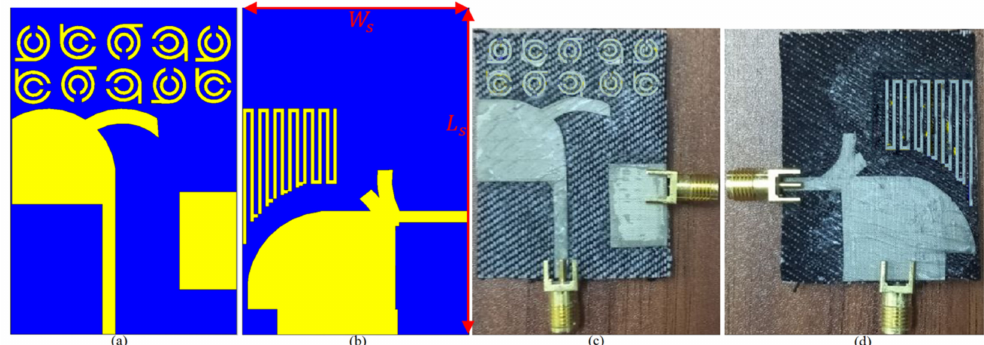
Figure 12. The final MAVA combined with the MTM: ( a , b ) the simulated structure, ( c , d ) the fabricated prototype (t, W s = 15 mm).